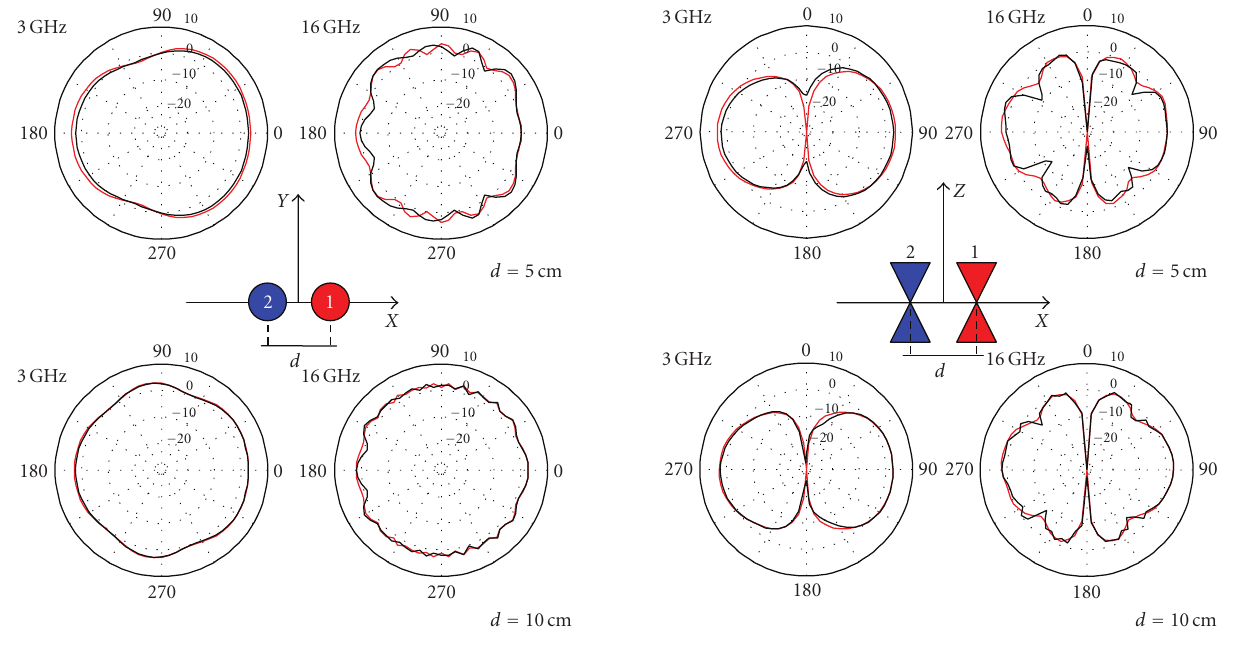
Figure 9: Expected azimuth (X-Y plane) radiation pattern for two antennas (solid line); SC approximation (red line) with scattering coe ffi cient averaged over the azimuth angle. Antenna 1 is excited; antenna 2 is open circuited.